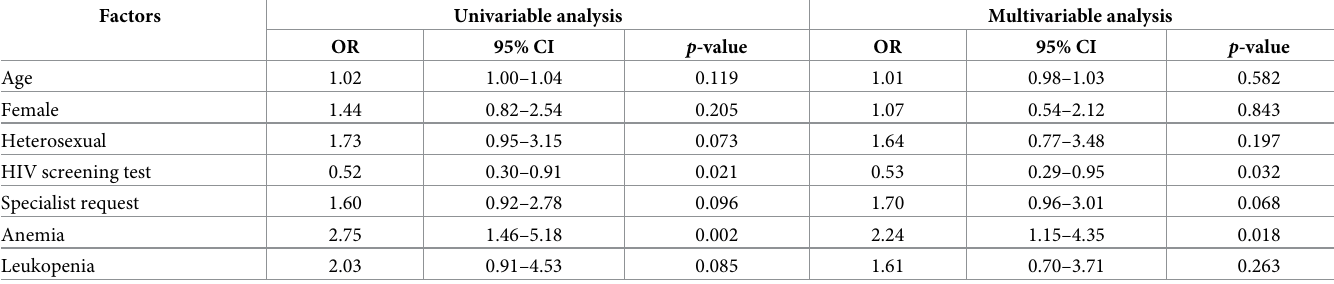
Table 3. Univariable and multivariable analyses of factors associated with missed opportunity for earlier diagnosis of HIV